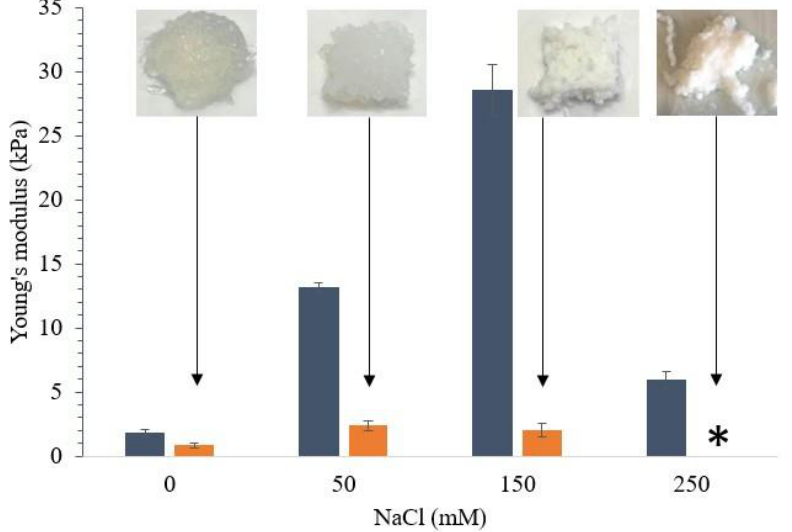
Figure 1. Young’s modulus of gels with 10% protein from whey protein isolate (WPI) with increasing NaCl concentration (0–250 mM). Dark blue bars show Young’s modulus before 3D printing. Orange bars show Young’s modulus after printing. Gels were prepared at pH 7. Samples marked with * could not be measured. Shown are averages of triplicate measurement and error bars as std. deviations.